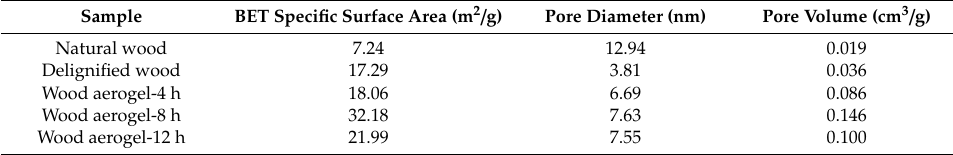
Figure 4. ( a ) Nitrogen adsorption–desorption isotherms of wood aerogel; ( b ) Mesopore size distribution of wood aerogel. Table 1. Specific surface area, pore diameter, and pore volume of wood samples.